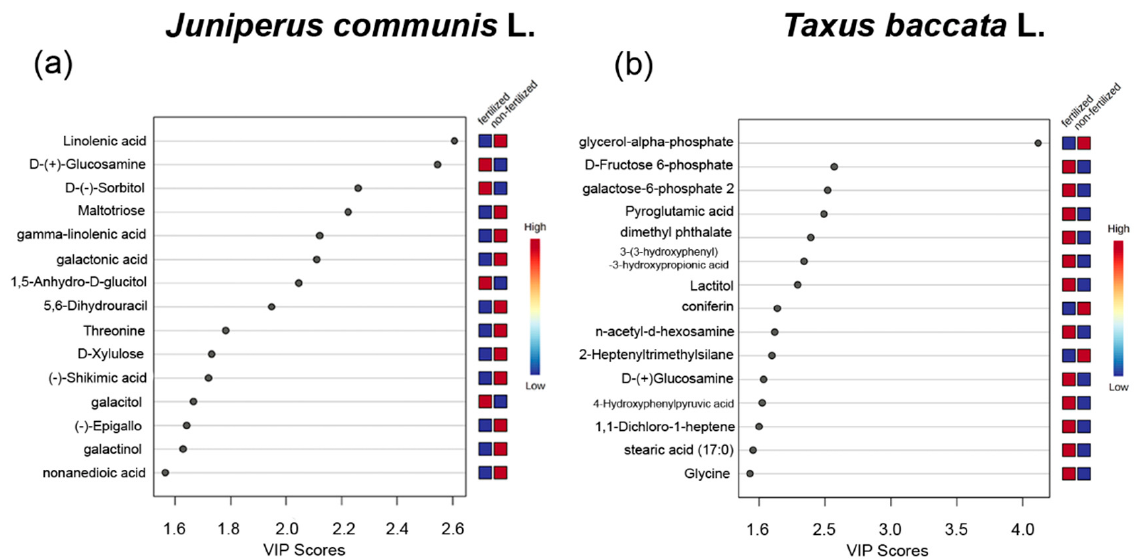
Figure 3. Results of the metabolome analysis of ( a ) Juniperus communis L. and ( b ) Taxus baccata L. pollen grains. VIP scores show the top 15 important metabolites that contribute the most to the PLS-DA plots of pollen grains. Colors in the variable importance in the projection plot represent relative intensities, where red and blue symbolize higher and lower values, respectively.